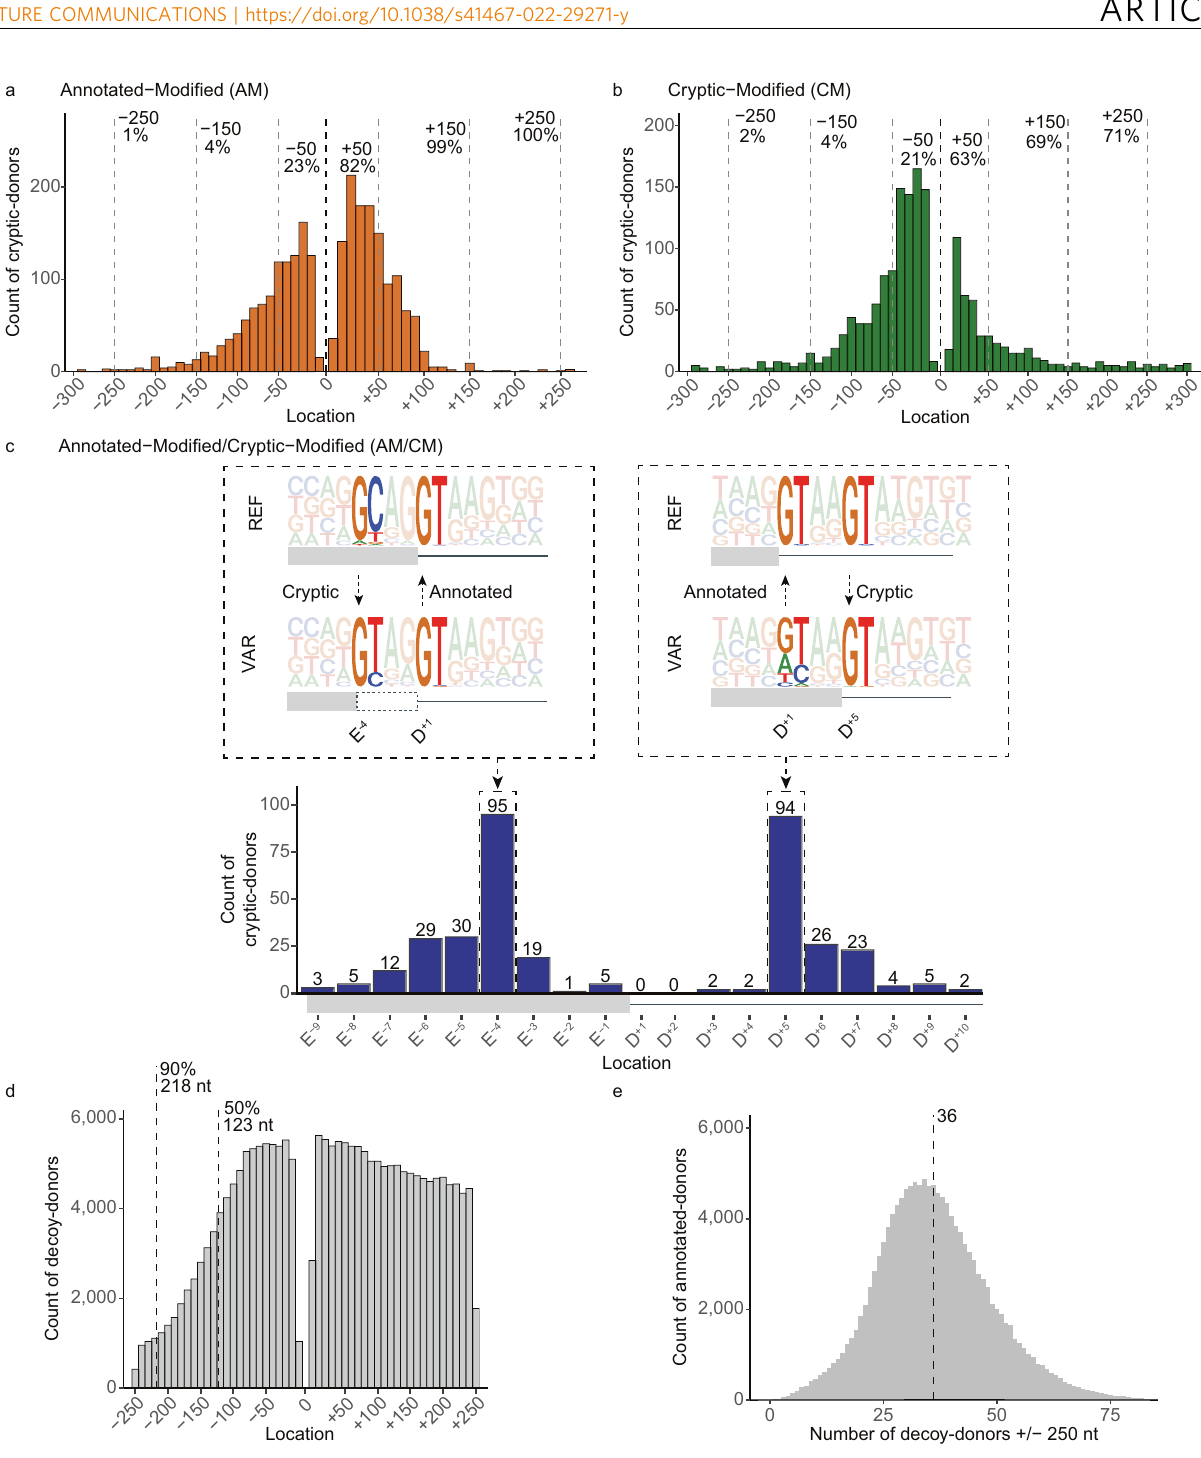
Fig. 2 Cryptic-donor activation is in fl uenced by proximity to the annotated-donor. a , b Distribution of cryptic-donors activated by ( a ) AM-variants and ( b ) CM-variants. Location (x-axis) denotes the distance of the cryptic-donor from the annotated-donor, with negative values upstream into the exon and positive values downstream into the intron. c (Bottom) Distribution of cryptic-donors activated by AM/CM-variants. (Top) Pictograms showing the Reference (REF) and Variant (VAR) sequences for AM/CM-variants. Activated cryptic-donors are prevalent at E -4 (left) and D + 5 (right) due to conserved GTs at D + 1/ + 2 and D + 5/ + 6 of the conserved donor splice-site sequence. d Frequency of naturally occurring decoy-donors (any GT or GC) + / − 250 nt of annotated-donors in the human genome. Dashed lines indicate the 50th and 90th percentile for exon length. The decline in exonic donors is due to relatively fewer longer exons. e Distribution of the number of decoy-donors in the + / − 250 nt surrounding each annotated-donor in the human genome. Dashed line shows that there are an average of 36 decoy-donors within 250 nt of each